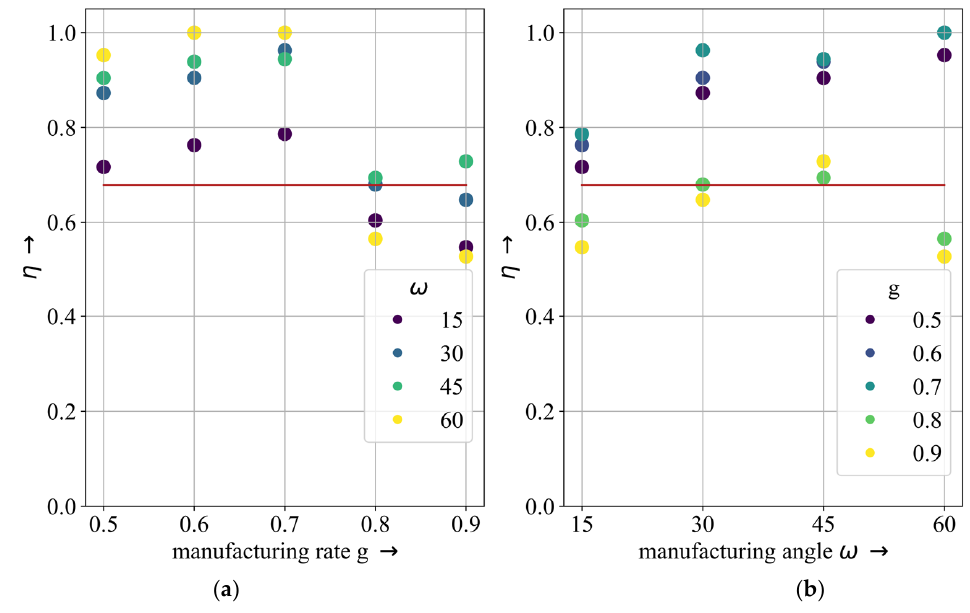
Figure 7. The effective material usage of the cantilever design proposals. The red line indicates η of the reference design proposal. ( a ) Shows the effective material usage η as a function of manufacturing rate g; ( b ) Shows the effective material usage η as a function of manufacturing angle ω . By application of the proposed method, η was increased to 100%.